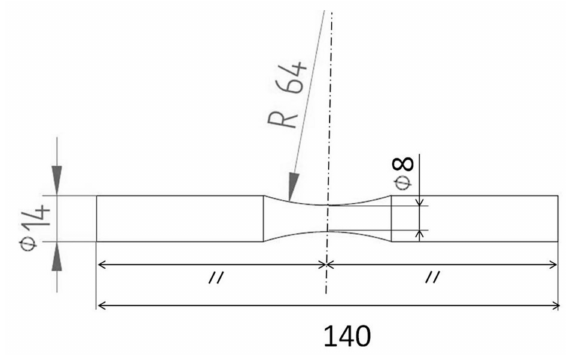
Figure 4. “Hourglass” specimen used in axial fatigue tests. Dimensions in millimeters.